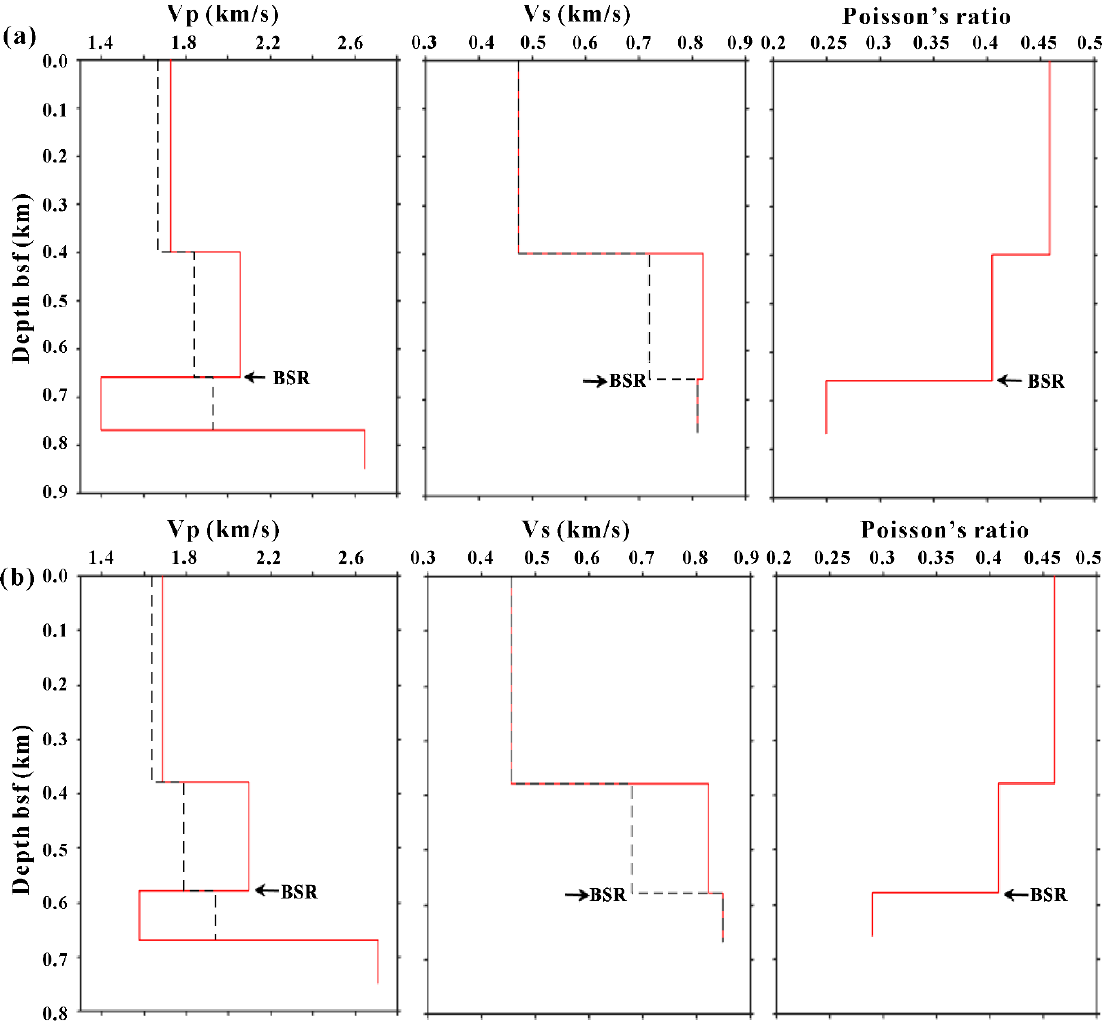
Figure 7. The seismic velocity profiles (red lines) after inversion and reference velocity curves (black dotted lines) and Poisson’s ratio profiles extracted at the locations of OBS 6 ( a ) and OBS 7 ( b ). Depth is measured below the seafloor (bsf).